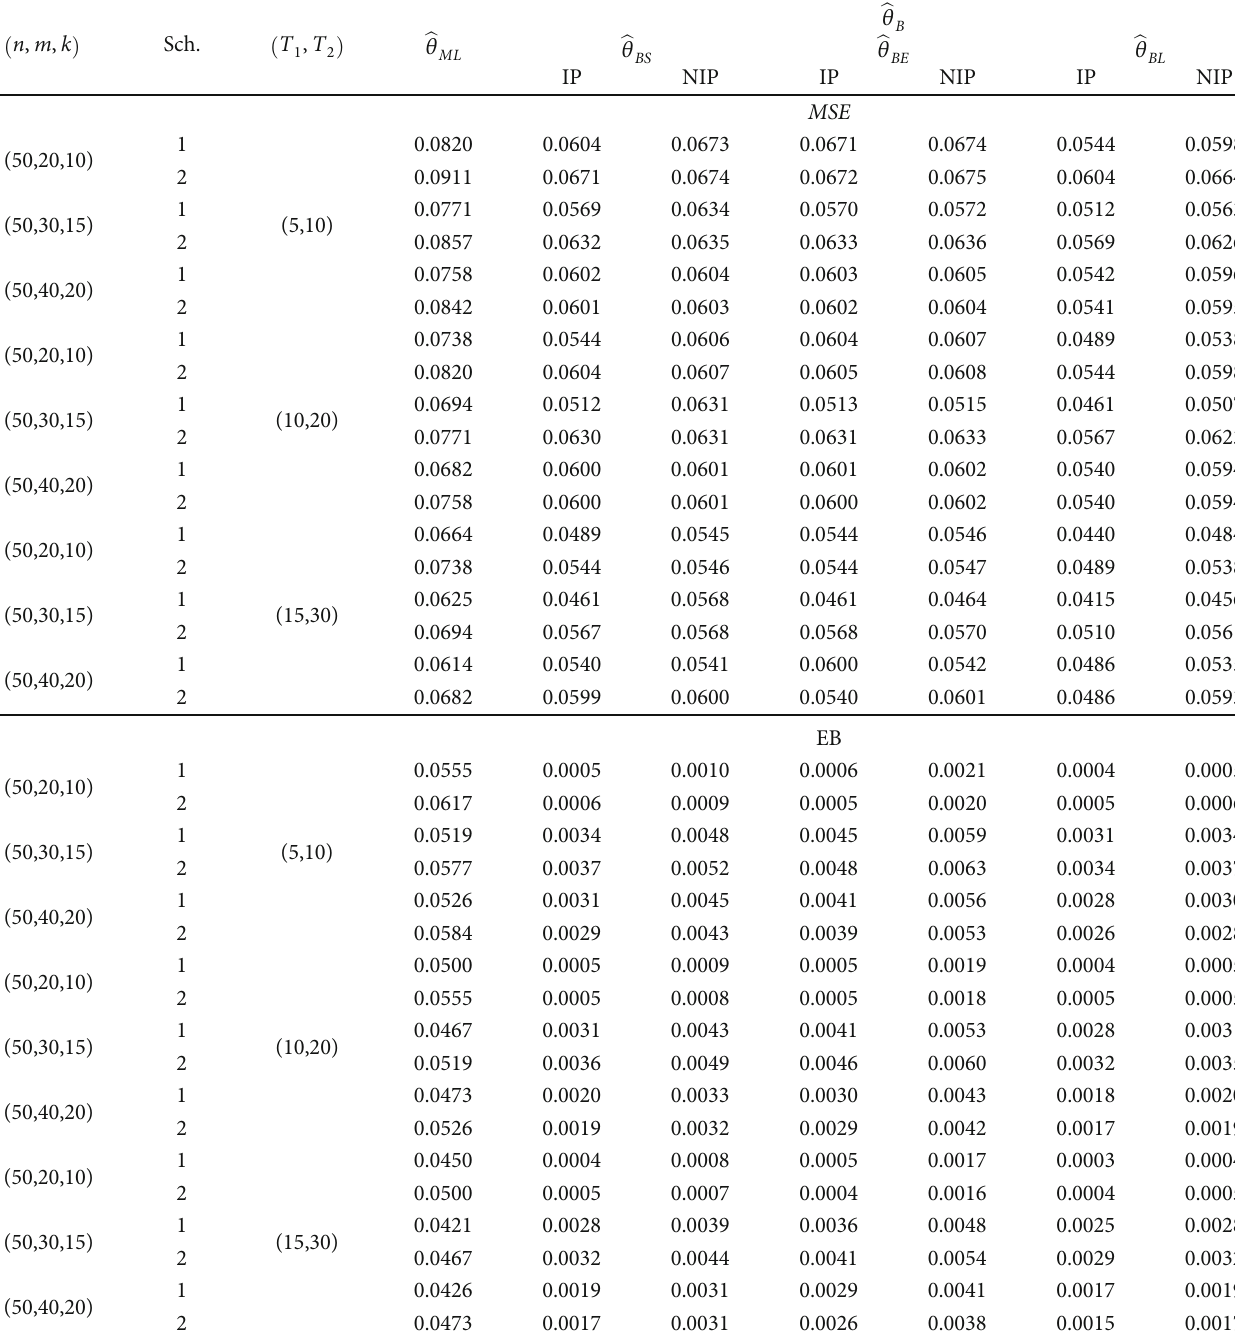
Table 2: The values of MSE and EB of ML and Bayesian estimates for θ based on the di ff erent Type-II uni fi ed UHCSs. n , m , k